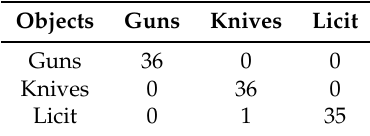
Table 9. Confusion matrix of lethal/licit object